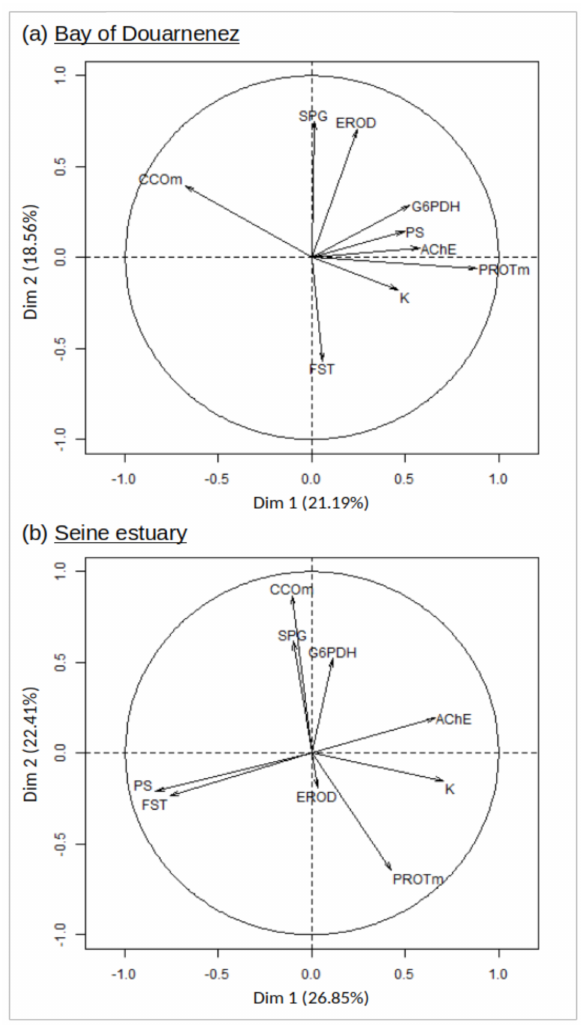
Figure 5. Principal component analysis (axes 1 and 2). Distribution of 9 markers on the correlation circle, in the Douarnenez and Seine populations. G6PDH: liver glucose-6-phosphate deshydrogenase, CCOm: muscle Cytochrome C Oxydase, EROD: liver e thoxyresorufine-O-d éé thylase, AChE: brain acetylcholine esterase, PROTm: muscle protein concentration, SPG: sphingomyelin, FST: free sterols, PS: phosphatidylserine, K: condition